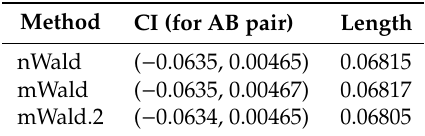
Table 4. nWald, mWald, mWald.2 90% confidence intervals (CIs) and CI lengths (between Group A and B pair) for North Carolina tra ffi c accident